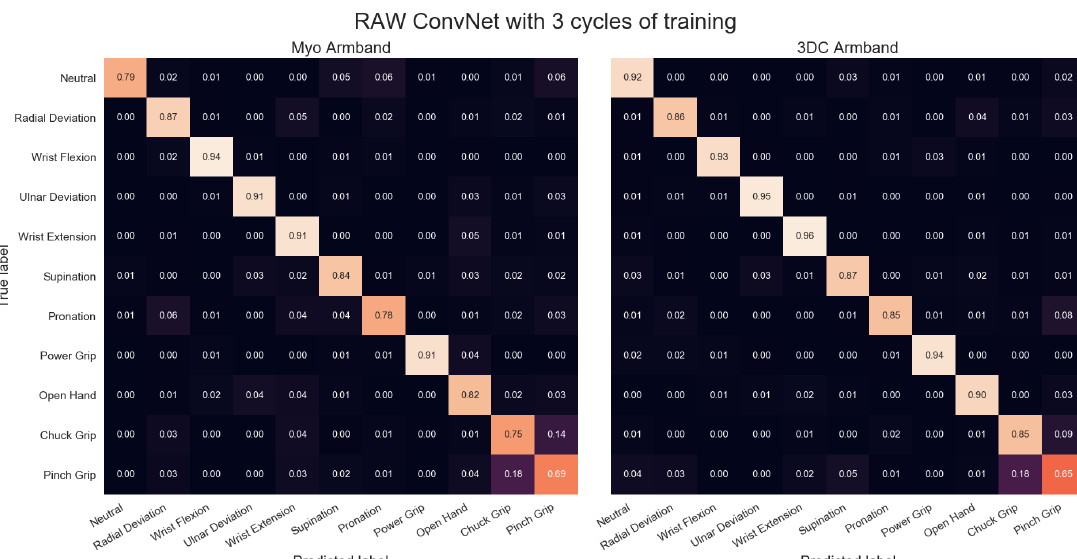
Figure A5. Confusion Matrices for the Myo and the 3DC Armband employing the Raw ConvNet for classification and two cycles of training. Lighter is better.